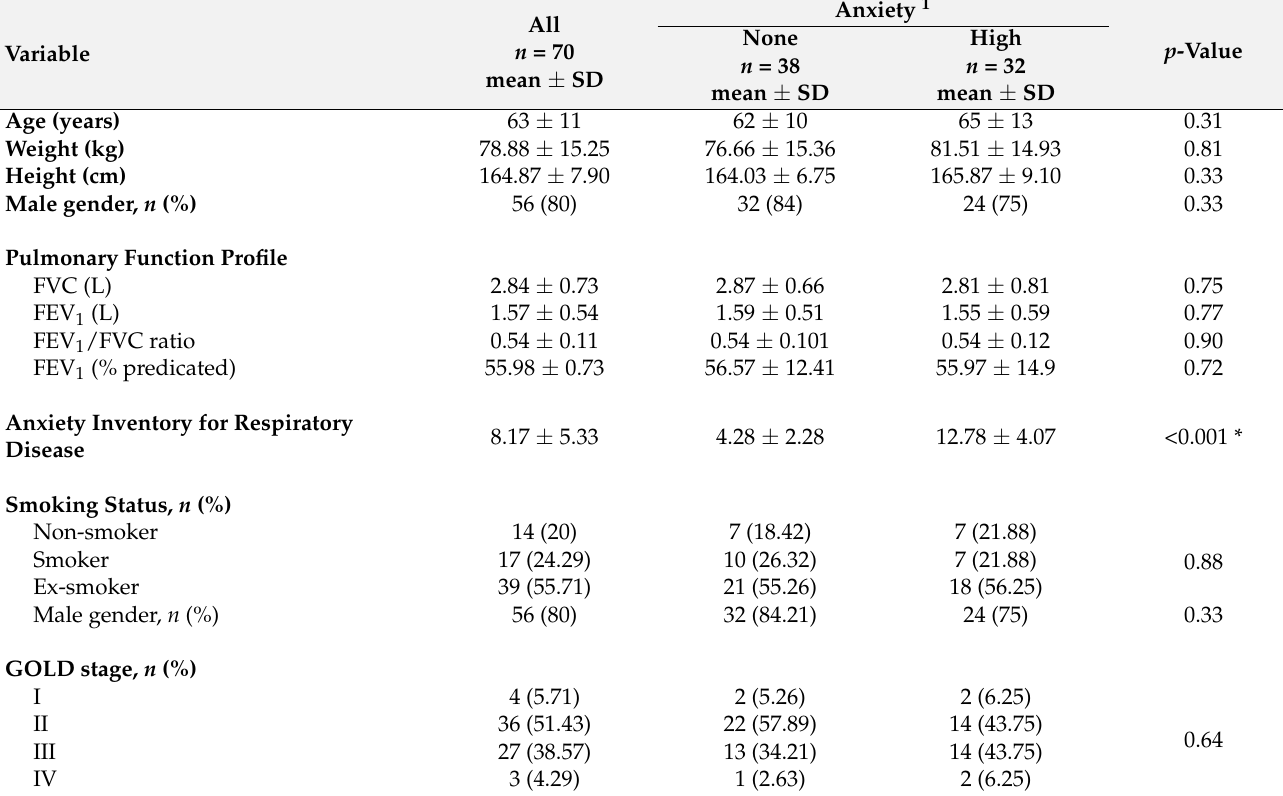
Table 1. Physical characteristics of the